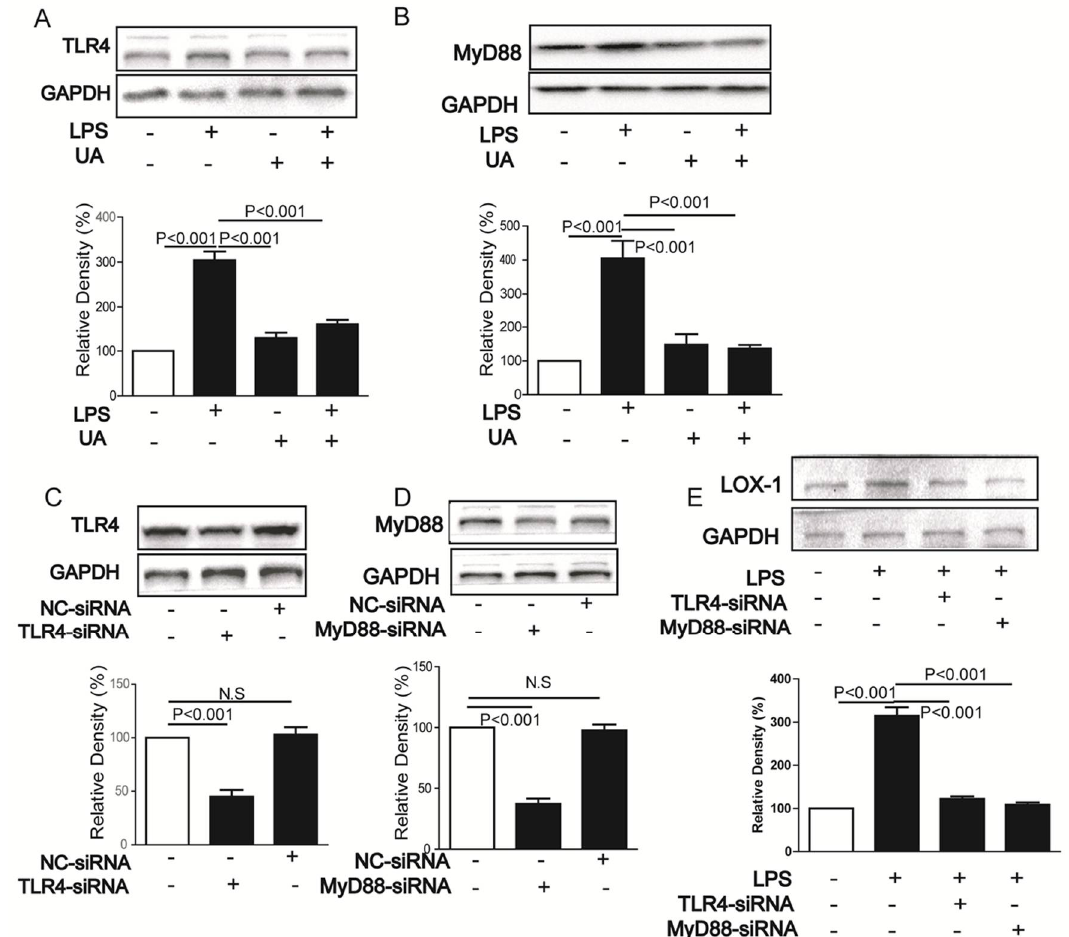
Figure 2. Cells were pretreated with UA (1 μM) for 1 h and then stimulated by LPS (5 mg/mL) for 24 h; expressions of TLR4 and MyD88 were determined by western blotting ( A , B ). Cells were transfected with siRNAs for TLR4 ( C ) and MyD88 ( D ) and then stimulated with LPS (5 mg/mL) for 24 h and the LOX-1 expression were determined by western blotting ( E ). Cont, control; NC-siRNA, negative control siRNA. UA, ursolic acid; N.S, no significant differences.